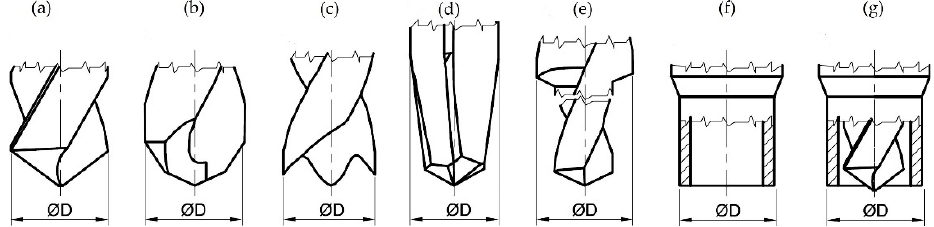
Figure 13. Morphologies of drill bits: ( a ) conventional twist drill, ( b ) double point angle (or double cone) twist drill, ( c ) brad and spur drill, ( d ) dagger drill, ( e ) step drill, ( f ) core drill and ( g ) special core drill [173].